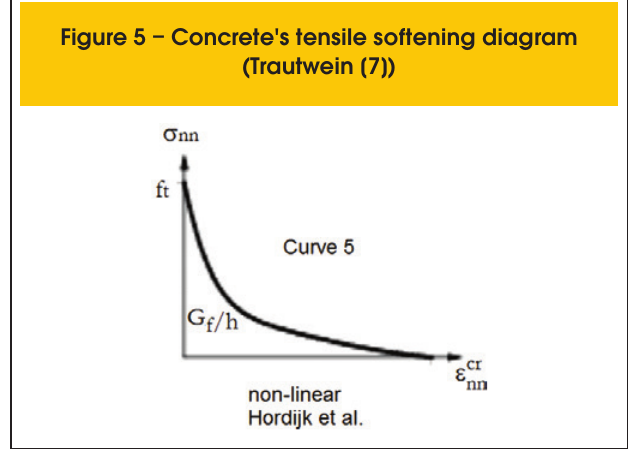
Figure 4 – Rebar concentration for Model 6